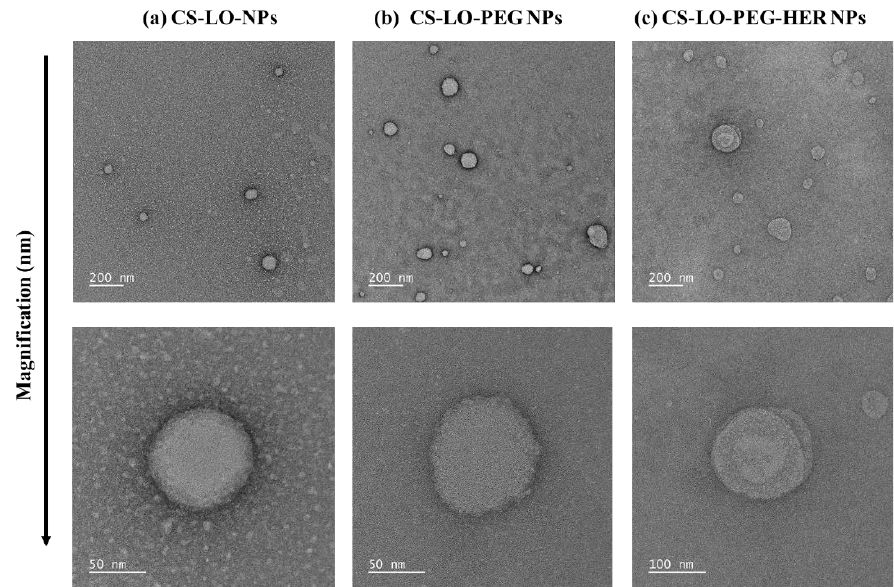
Figure 1. Transmission electron microscopic observation of HER functionalized L- lysine α -oxidase loaded chitosan-polyethylene glycol (PEG) nanoparticles. CS-LO NPs ( a ), CS-LO-PEG NPs ( b ) and CS-LO-PEG-HER NPs ( c ). Where CS is chitosan, LO is L- lysine α -oxidase, PEG is Polyethylene glycol 600, HER is Herceptin (Trastuzumab).